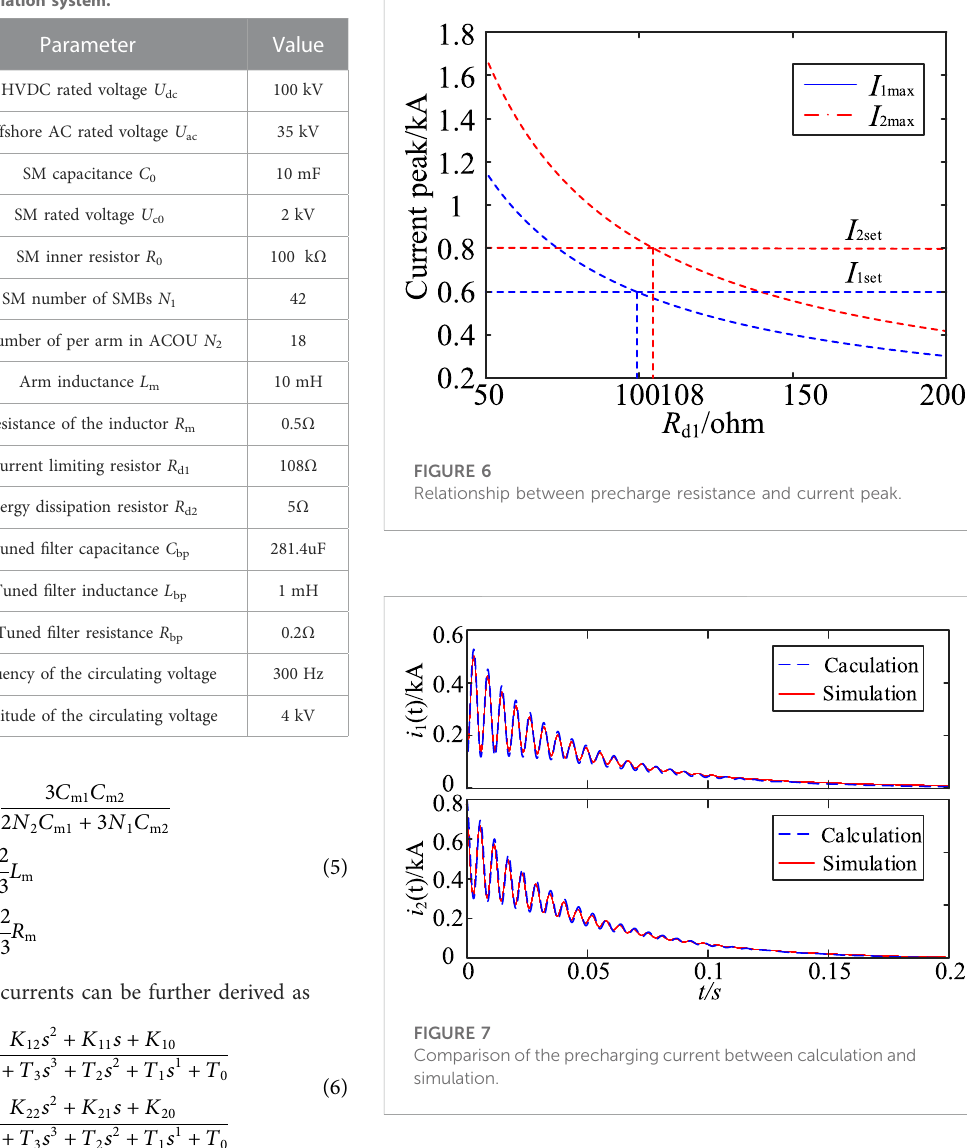
TABLE 1 Parameters of the simulation system.